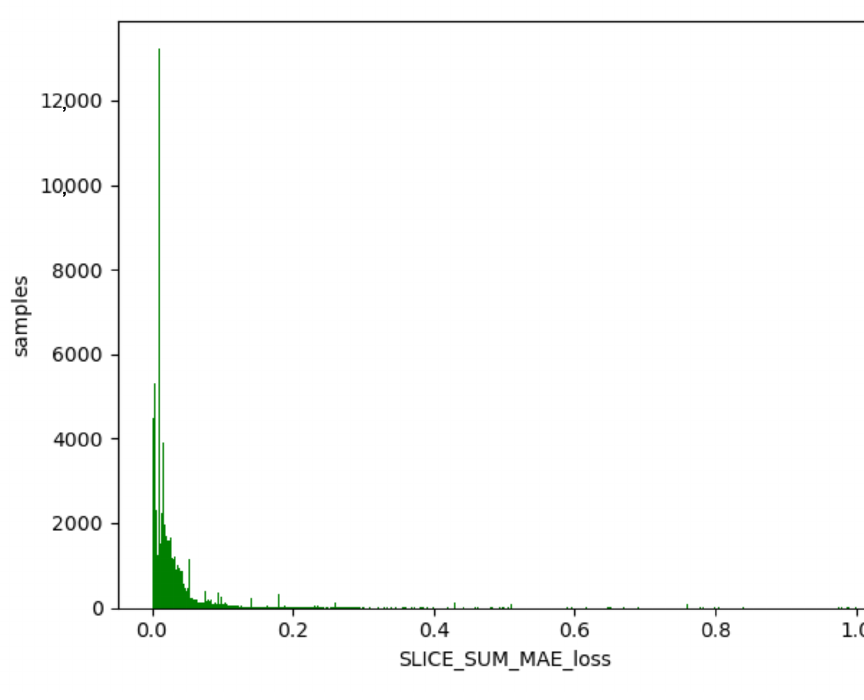
Figure 14. KDD99 training set. Green indicates normal